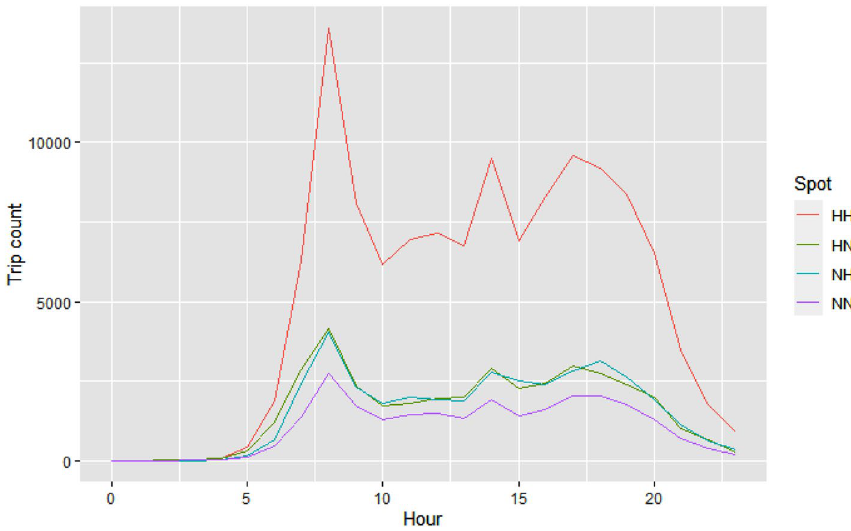
Figure 5. Temporal average number of hourly trips within different flows.